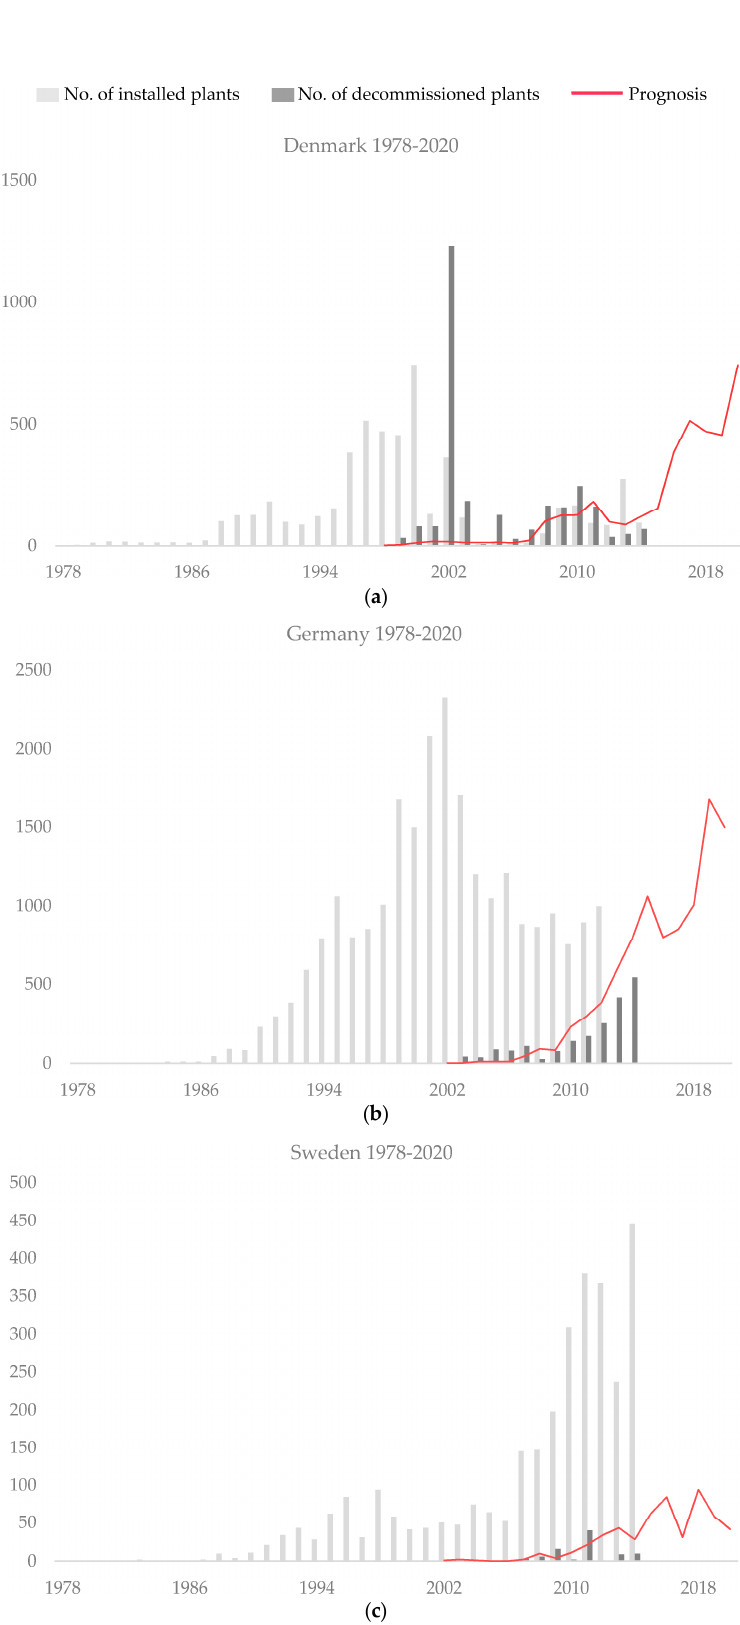
Figure D1. Actual installed and decommissioned wind turbines compared to expected number of decommissioning’s assuming an average of 20 years’ life time in: ( a ) Denmark; ( b ) Germany; and ( c ) Sweden [70,74–79]. Note the difference in magnitude between charts, not allowing for comparison between